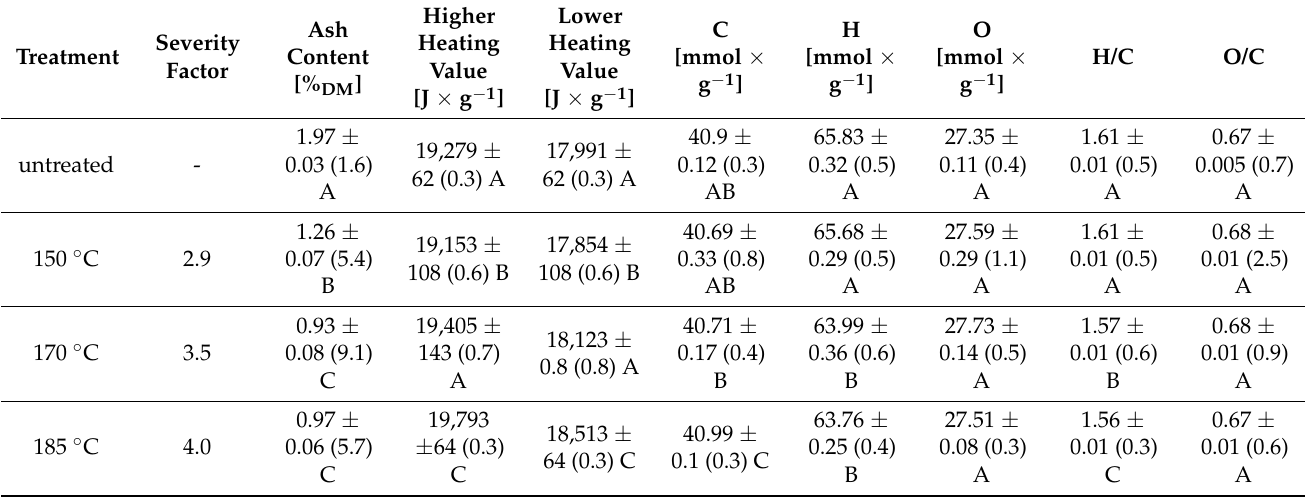
Table 1. Data of the calorimetric and elemental analysis of the HTT treatment (mean ± standard deviation (coefficient of variation)). Different letters indicate significant differences of p < 0.05 between the